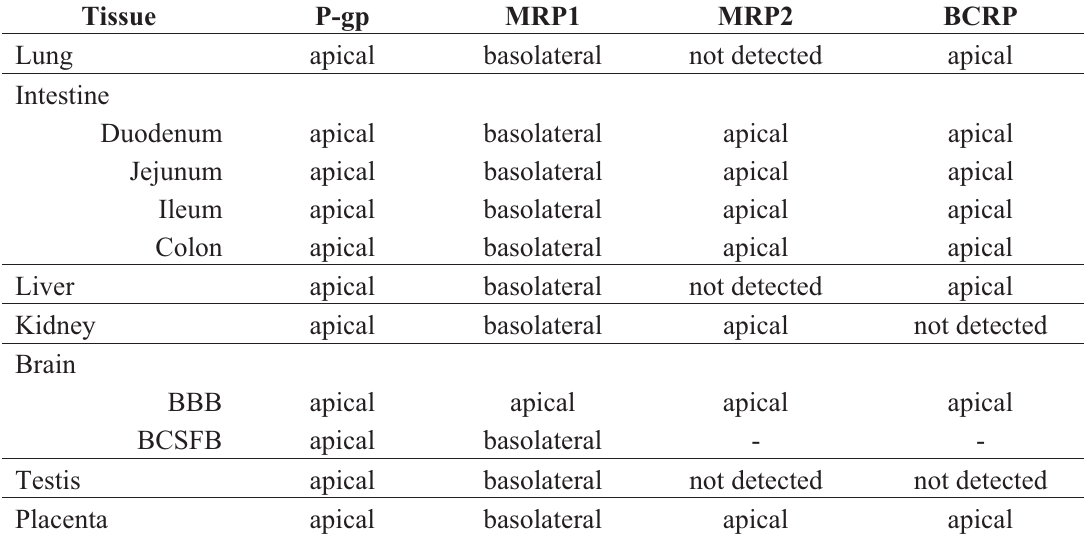
Table 2. Overview of distribution of the ABC transporters P-gp, MRP1, MRP2 and BCRP in selected human barrier tissues